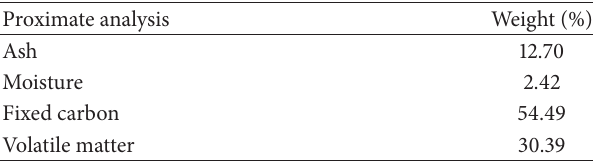
Table 1: Analysis values of coal (air dried basis). Proximate